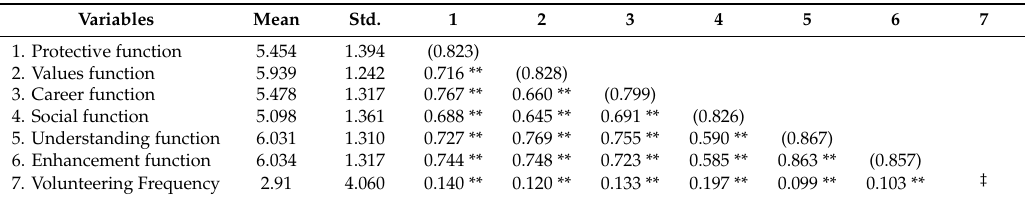
Table 3. Descriptive statistics and correlations (N = 1992).